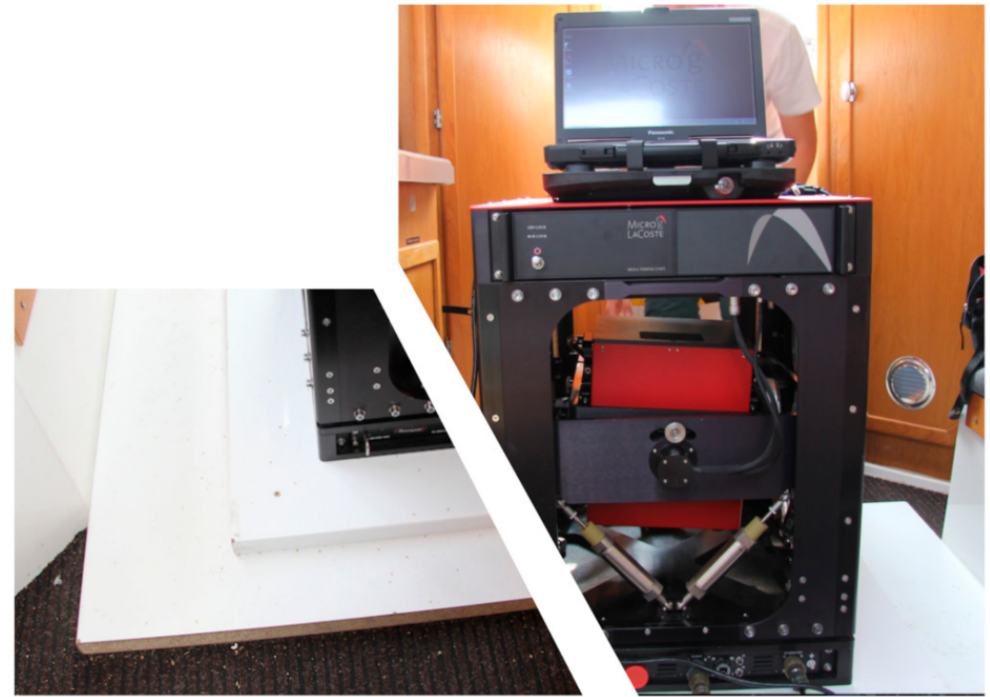
Figure 3. MGS-6 mounted on the survey vessel. On the left is shown how the frame was fitted to the deck using thick chipboard